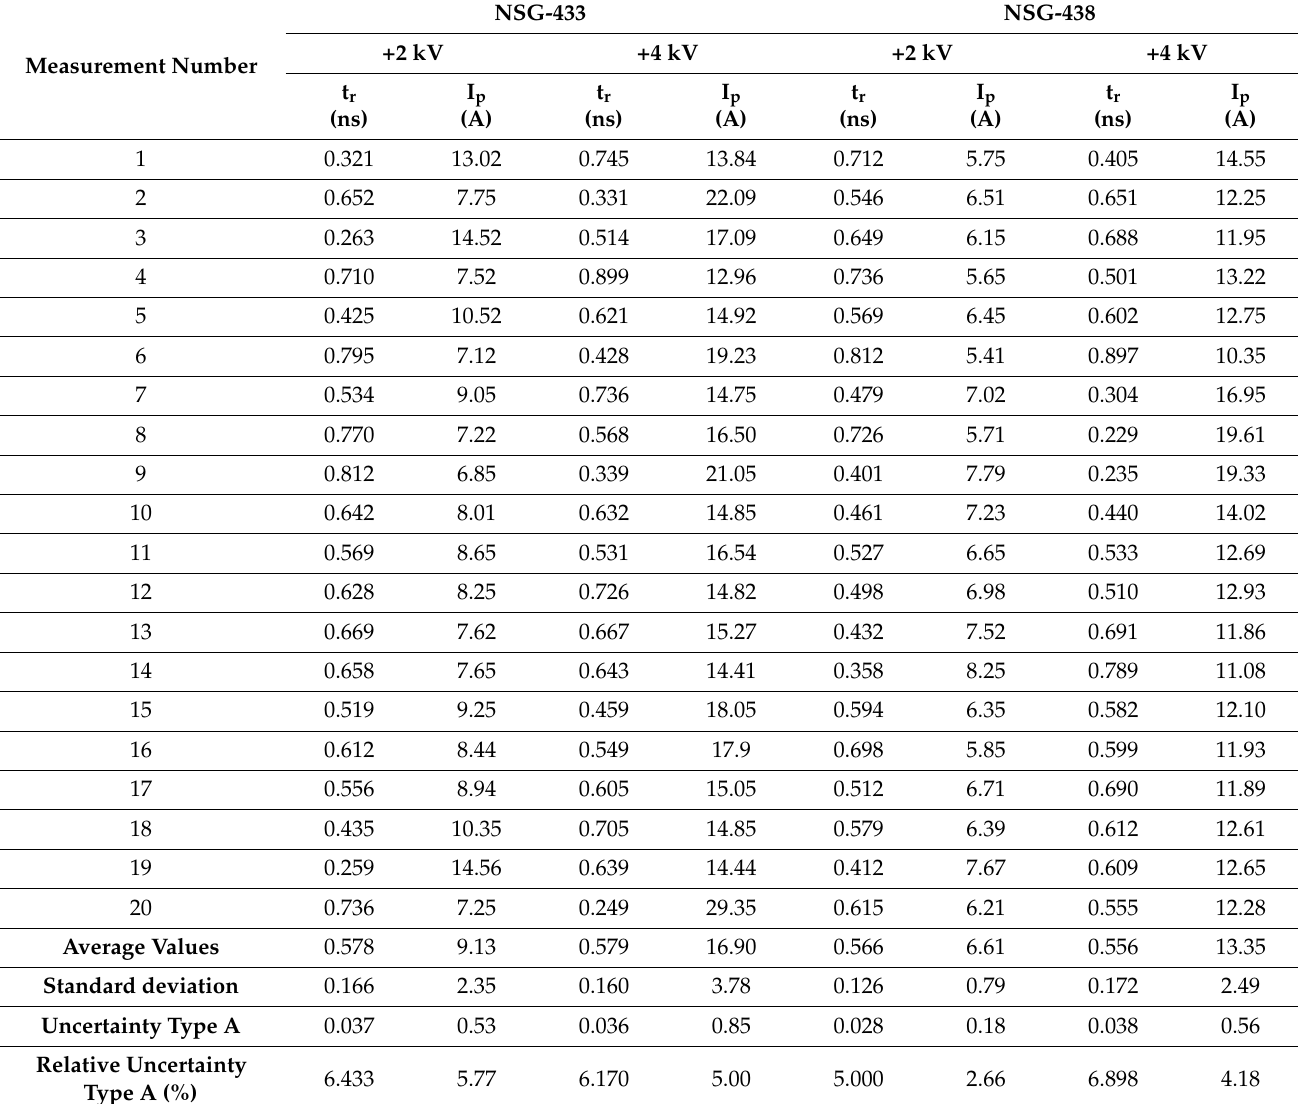
Table 2. Rise time and peak current measurements for two different ESD guns and for two different charging